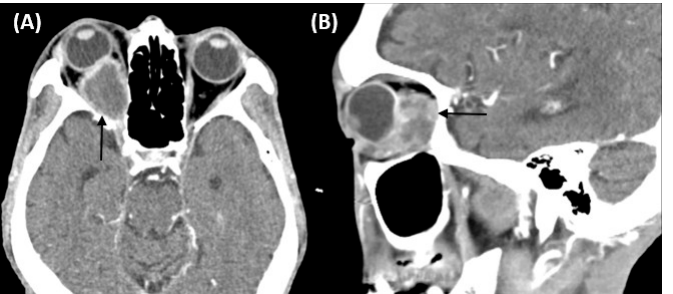
Figure 2. Computed tomography of the orbit demonstrating a soft tissue lesion measuring 3.3 × 2 × 2 cm in the right orbital fossa with peripheral enhancement (black arrow). The right globe and optic nerve are compressed, causing exophthalmos. ( A ) Axial image. ( B ) Sagittal image.